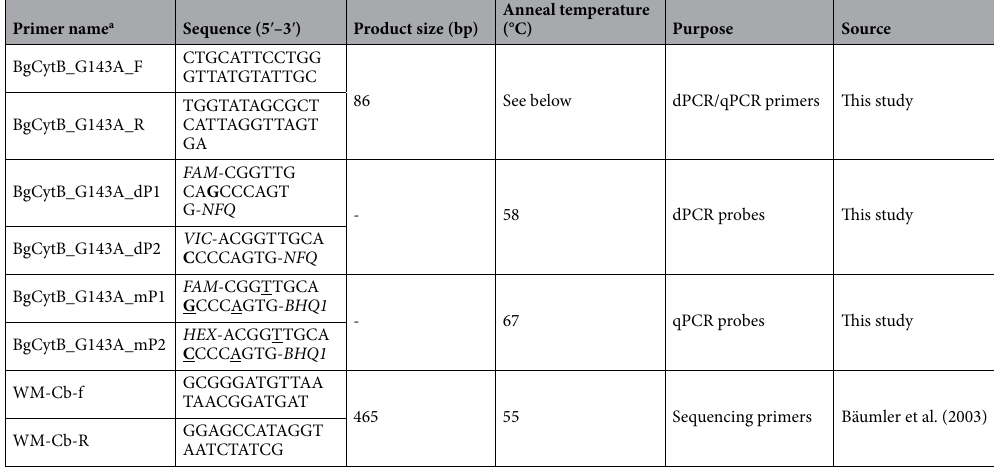
ratios (R 2 = 0.999), with the lower level of quantification of the mutant allele determined to be 0.33%, and the allele detectable at 0.07% (Table 4; Supplementary Fig. S1). No cross-reaction was found when genomic DNA from other common wheat pathogens was tested, however, the closely related barley powdery mildew pathogen Blumeria graminis f. sp. hordei was positive for the G143 allele (Table 3).